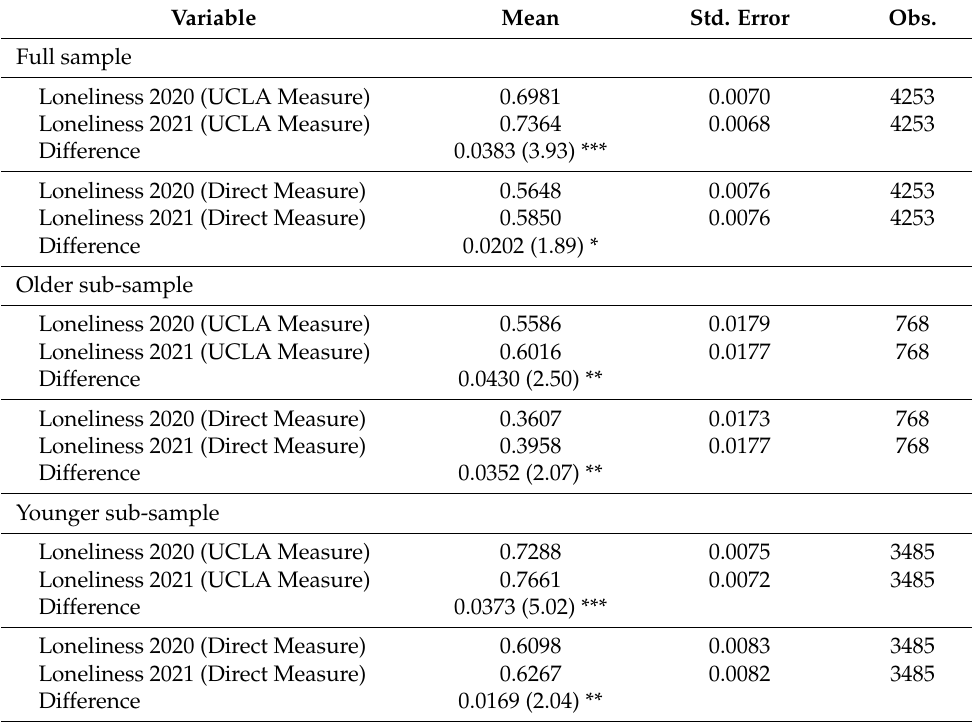
Table 3. Comparison of loneliness before and during the COVID-19